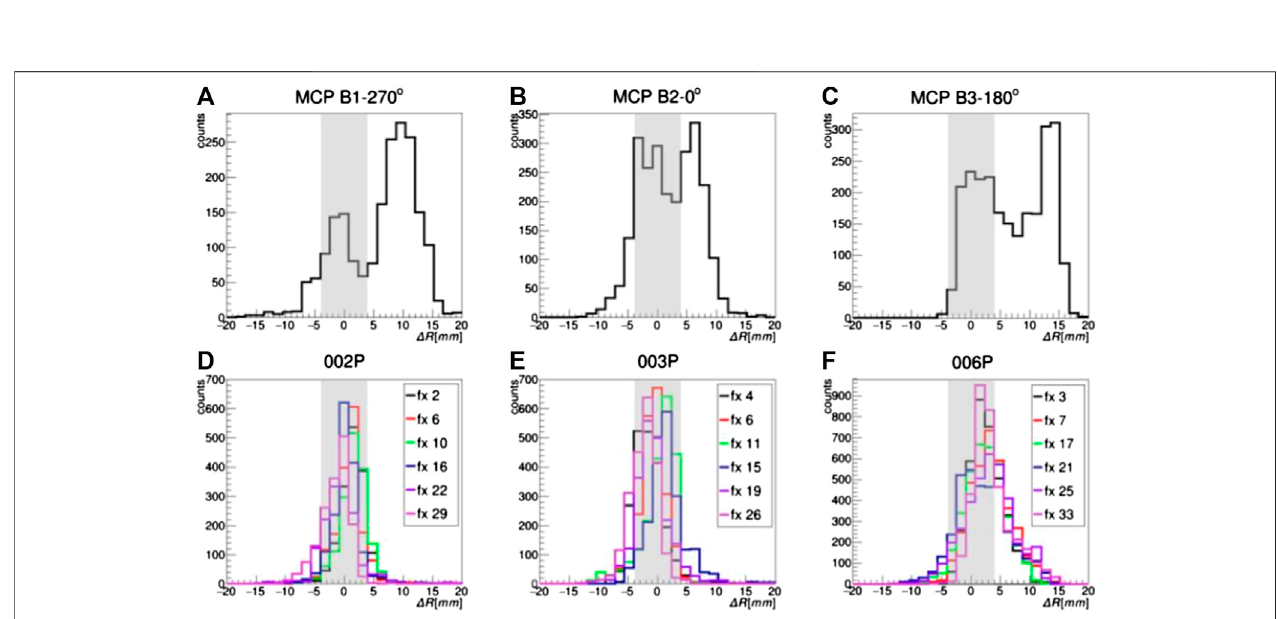
FIGURE6| Distributionsof Δ R i , j ( x , y ) values.The Δ R i , j ( x , y ) valueshighlightedingrayareconsiderednotstatisticallyrelevantwithacon fi dencelevelof95%. Upper row: comparison of the activity distribution of the planning and control CTs obtained for the replanned simulated patient: (A) B 1 – 270 ° fi eld; (B) B 2 – 0 ° fi eld; and (C) B 3 – 180 ° fi eld. Bottom row: comparison between the fi rstmonitored fraction (fx) and subset offractions acquired inthefollowing days: (D) patient 002P( fi rst monitored fraction fx1); (E) patient 003P ( fi rst fraction fx1); and (F) patient 006P ( fi rst fraction